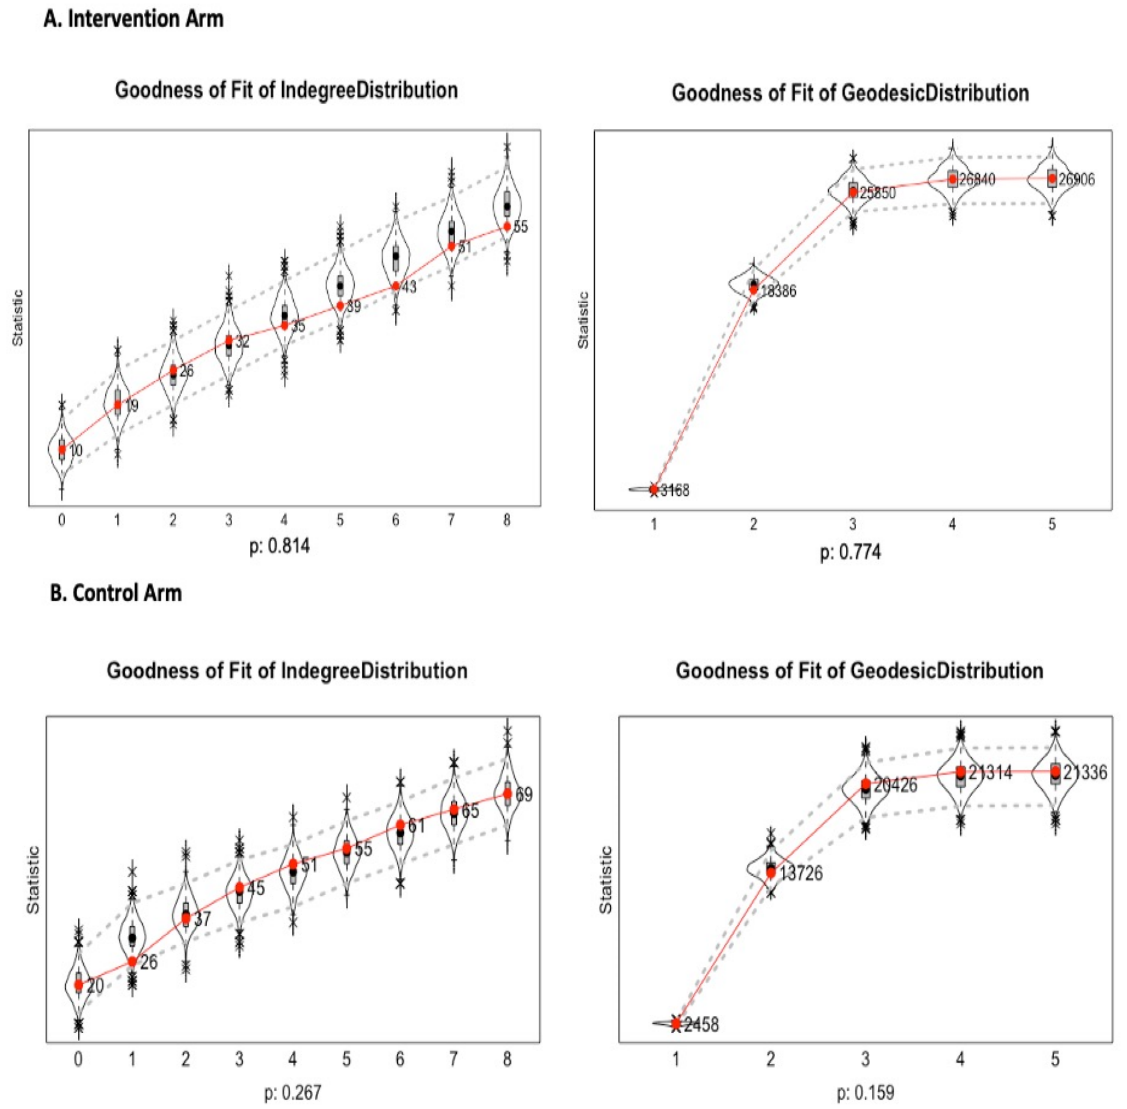
Figure A1. Goodness of fit statistics for the ( A ) intervention arm and ( B ) control arm